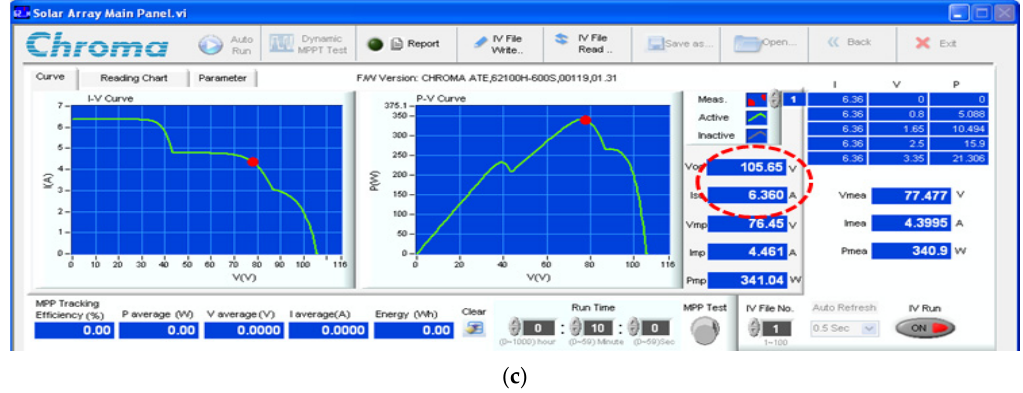
Figure 24. P ‐ V and I ‐ V curves under PSC for irradiations of ( a ) 1000 W/m 2 ; ( b ) 800 W/m 2 and ( c ) 600 W/m 2 .